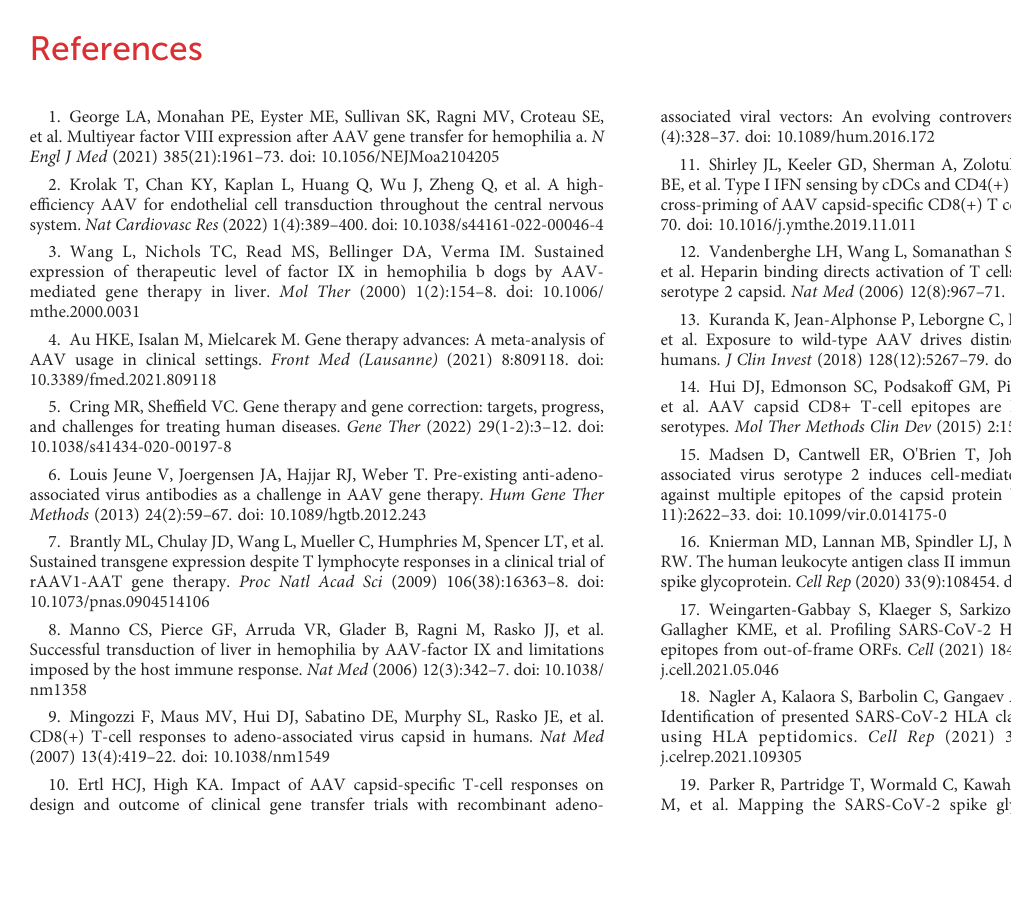
SUPPLEMENTARY TABLE 2 Clusters identi fi ed in the study. Related to Figures 2, 3.